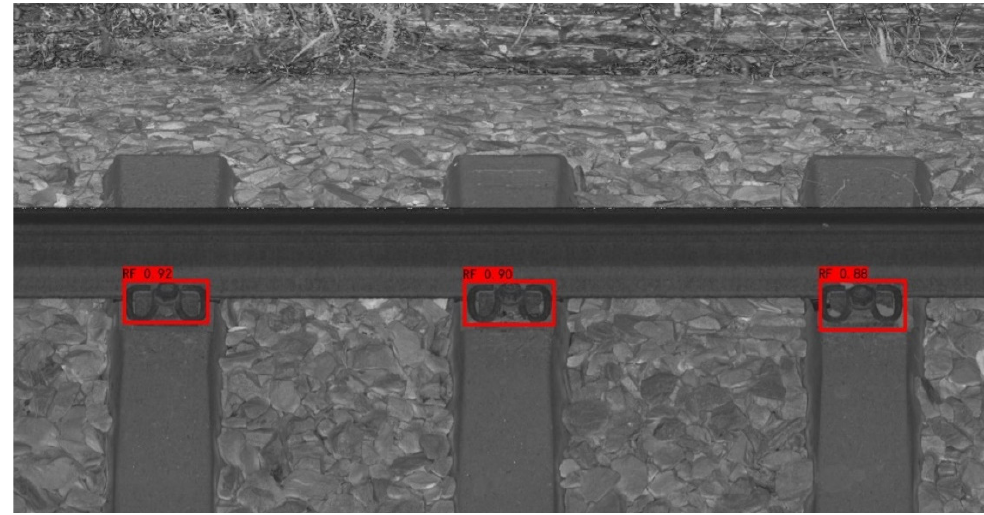
Figure 12. Feature point recognition results. Table 1. Mileage positioning